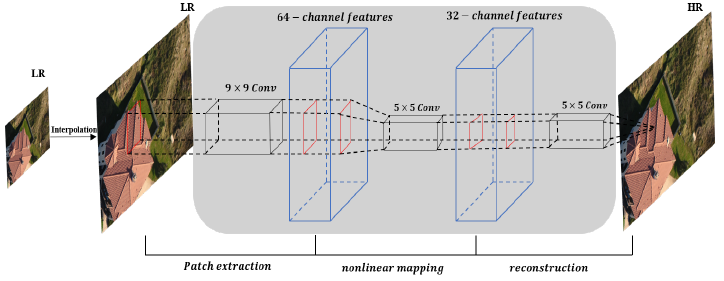
Figure 2. Sketch of the SRCNN